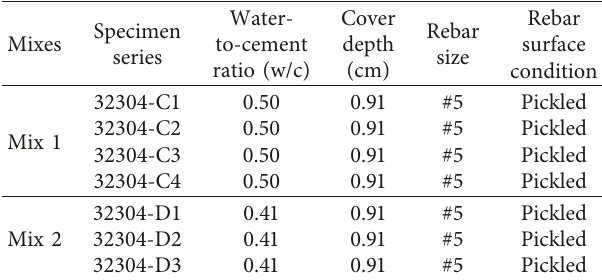
Figure 2: A couple of mortar specimens with CRA rebars (front view). Table 3: Details of specimen